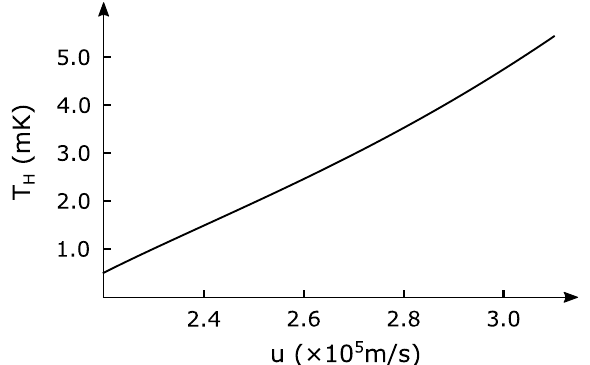
8 A 2 10 8 Hz , 10 , ω 0 − = × =